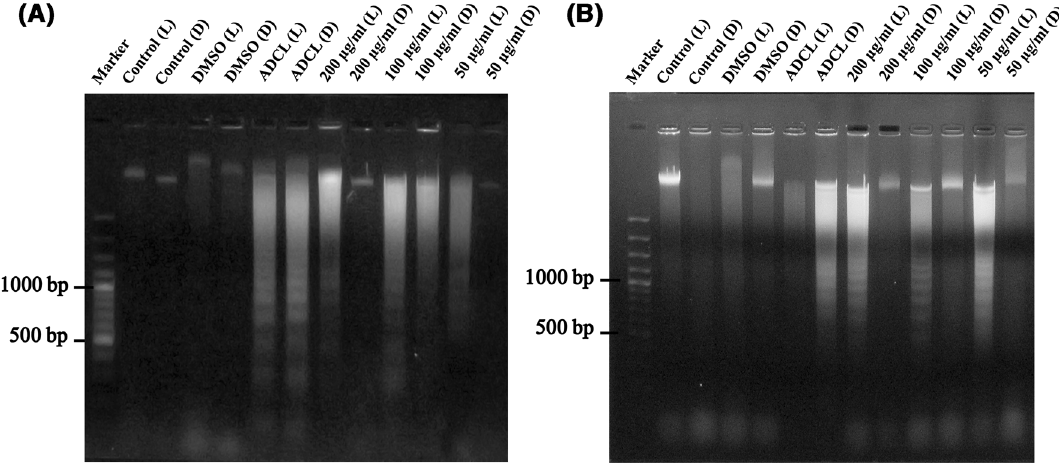
Fig. 4 Detection of DNA fragmentation in U937 and SK-HEP-1 cells by BNCE and light treatment. Cells were treated with BNCE (50, 100, and 200 l g/ml) for 4 h. Cells were irradiated with light for 10 min or kept in the dark, followed by incubation for 6 h. Cells were harvested,